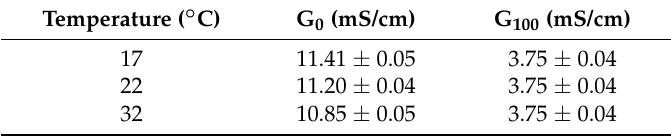
Table 2. Calibration of conductivity values at different